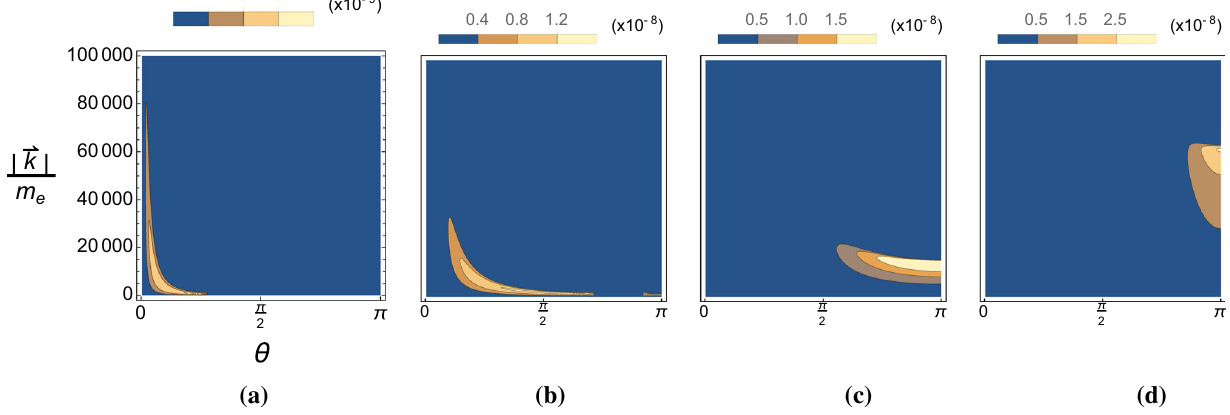
Fig. 8 The pseudo-scalar yield, P − , is plotted as a function of the angle and momenta of the emitted ALP in a Gaussian background with m φ = 0. a χ p , 0 = 0 . 1, b χ p , 0 = 1, c χ p , 0 = 10, d χ p , 0 =